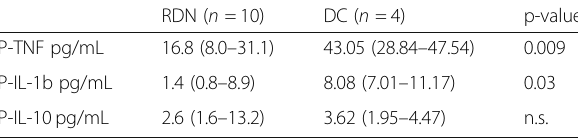
Table 2 Baseline cytokine levels in RDN-patients and